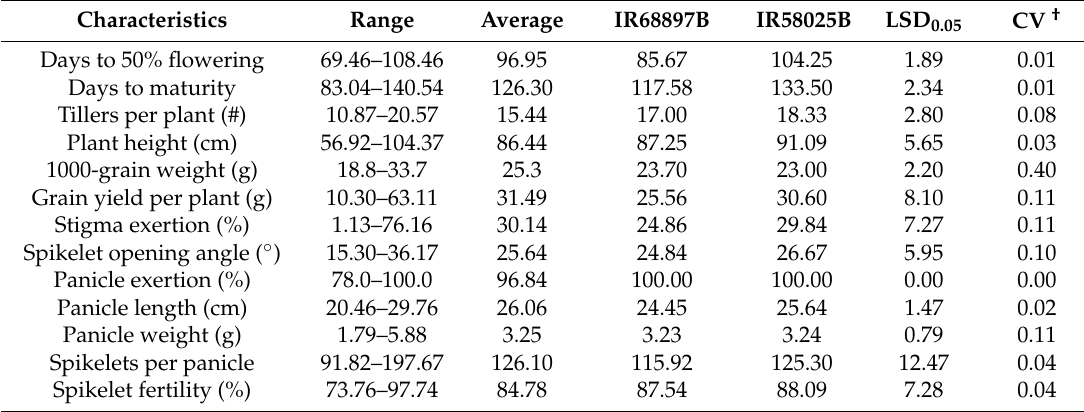
Table 2. Range and average for agronomic and floral characteristics of 216 maintainer lines and two